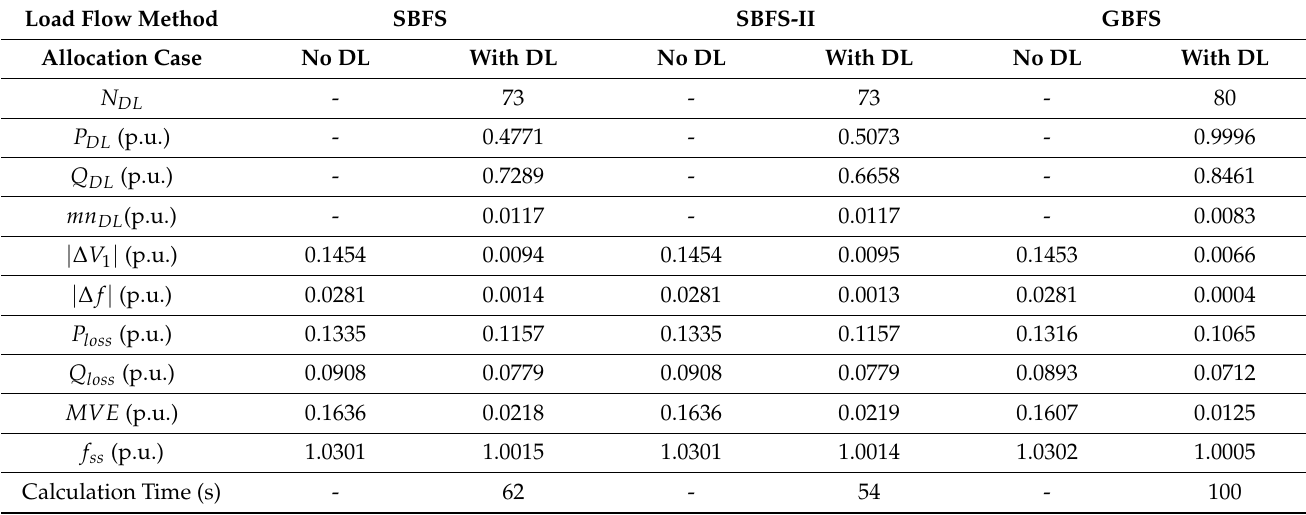
Table 9. Multi-objective results with different load flow methods for the 118-bus